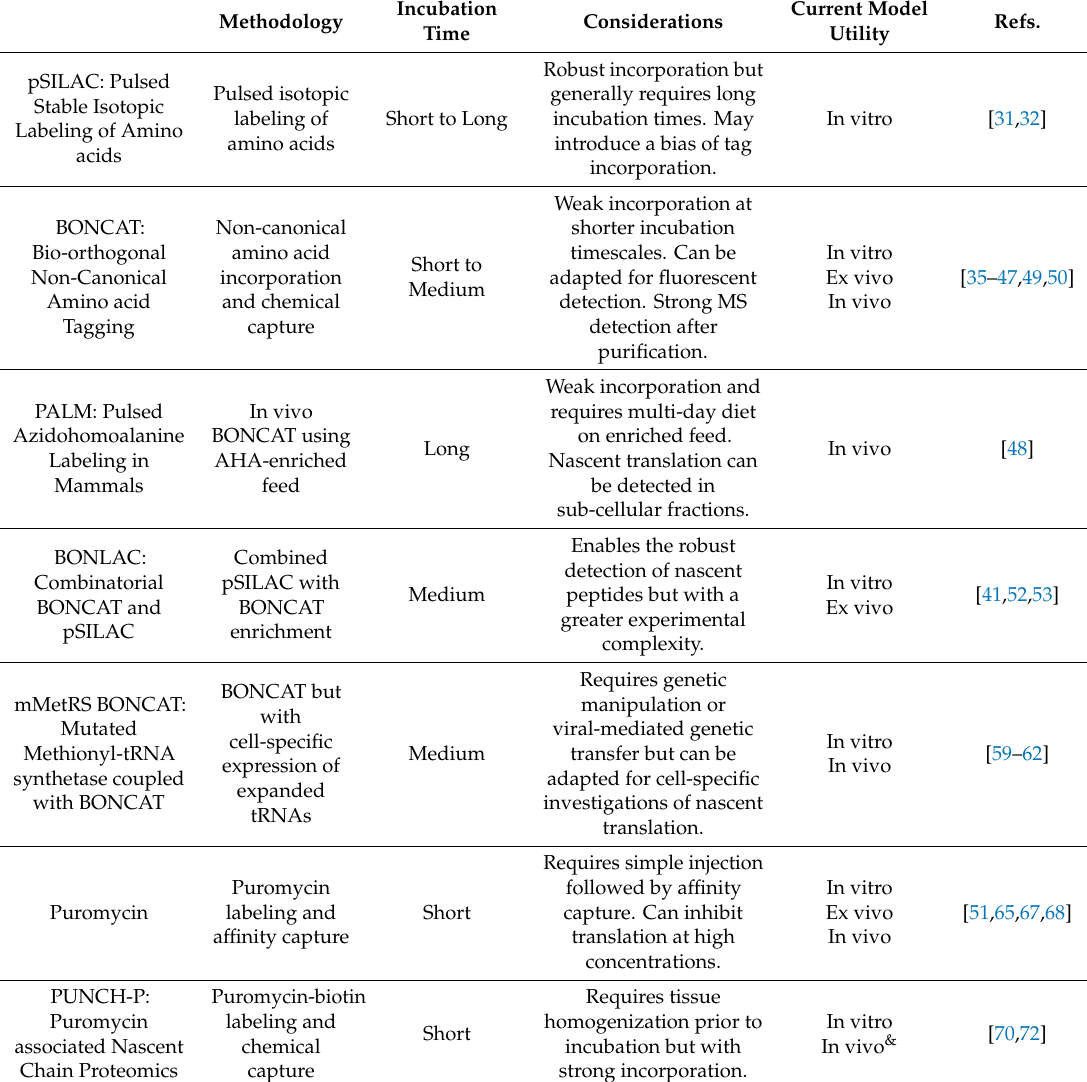
Table 1. Comparisonofproteomictechniquesthatfocusonthenascentproteomeandexperimentalconsiderations.